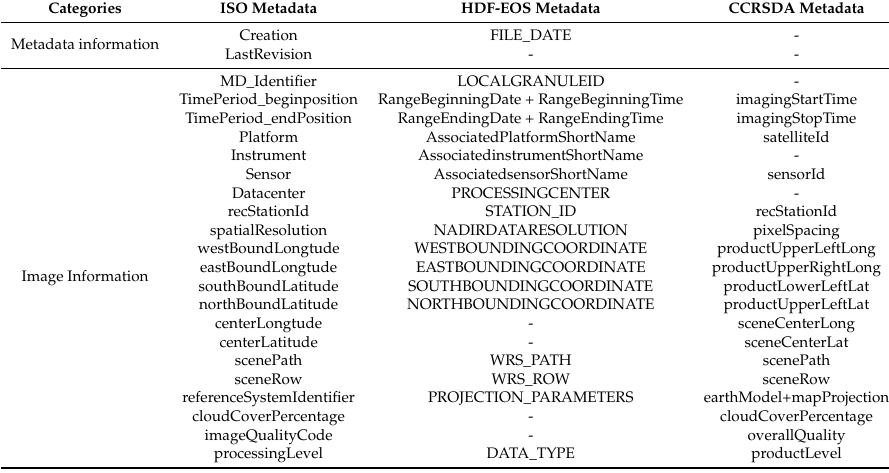
Table 1. The ISO 19115-2:2009-based uniform metadata format and transformational rules. ISO: International Standardization Organization; CCRSDA: China Center for Resources Satellite Data and Application; HDF-EOS: Hierarchical Data Format Earth Observation